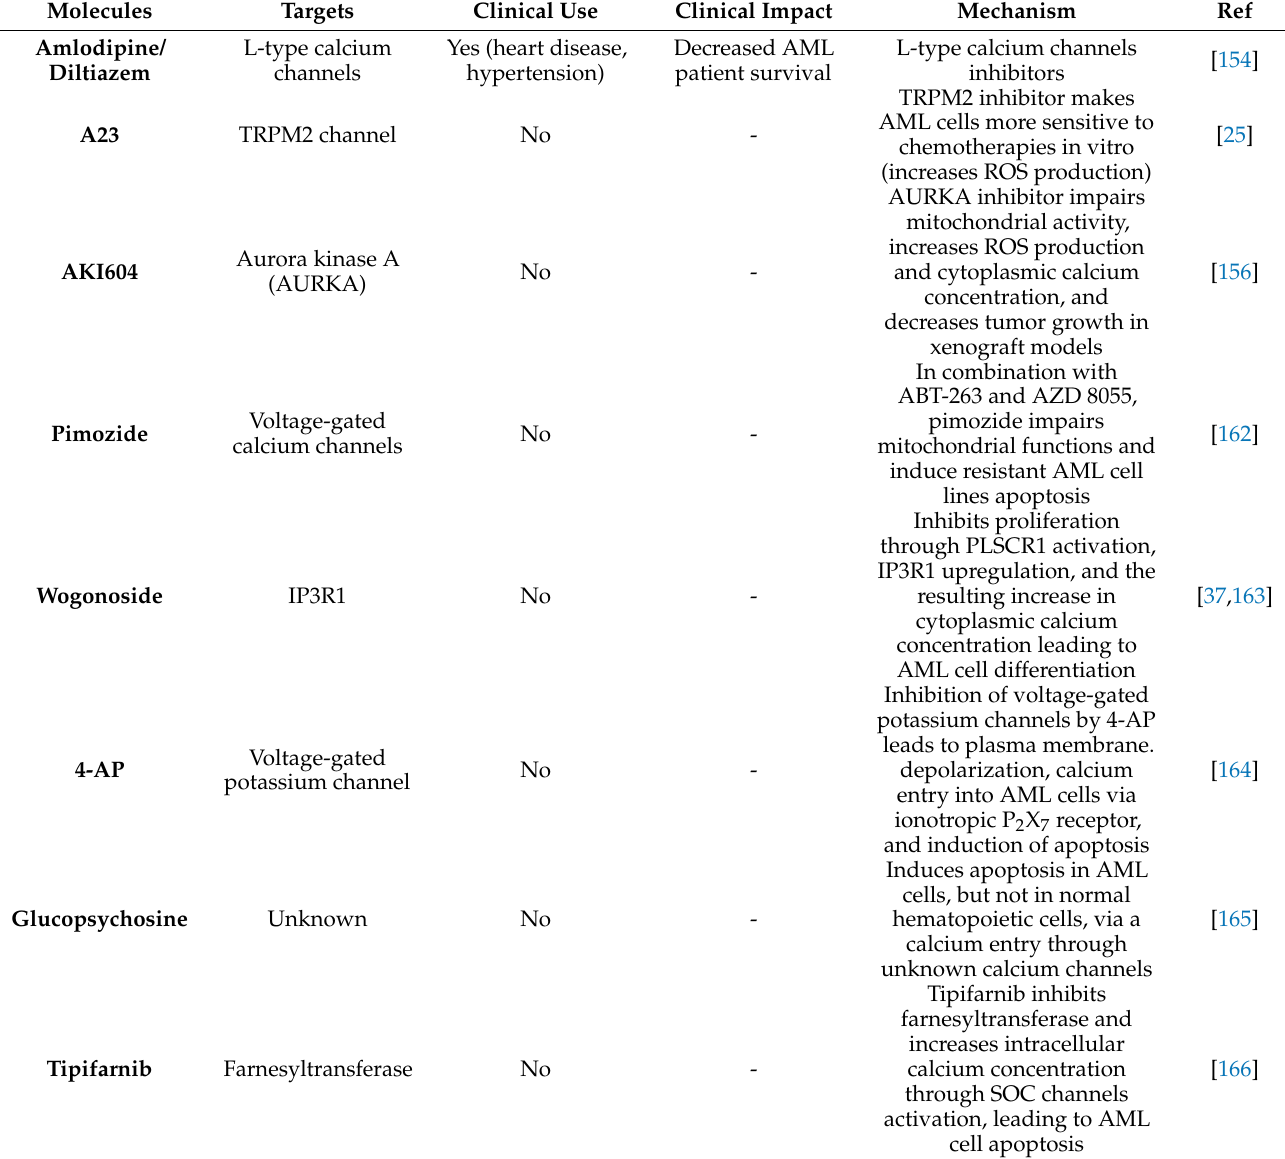
Table 2. Summary of the main molecules with chemotherapeutic potential targeting the calcium signaling pathway in